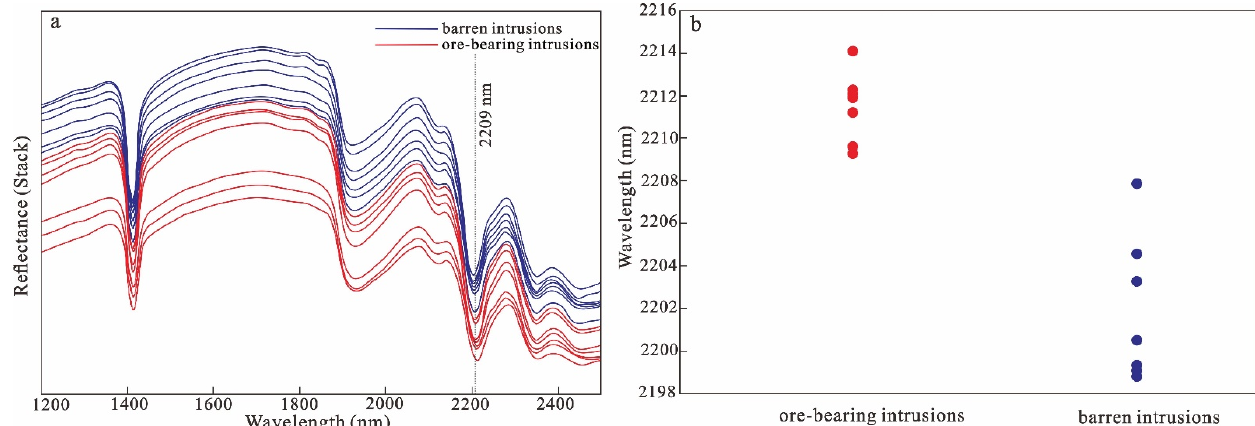
Figure 3. ( a ) SWIR spectra of white micas from ore-bearing intrusions and barren intrusions; ( b ) Statistical diagram of SWIR spectra absorption feature wavelengths (2198–2216 nm) for white micas from ore-bearing intrusions and barren intrusions.